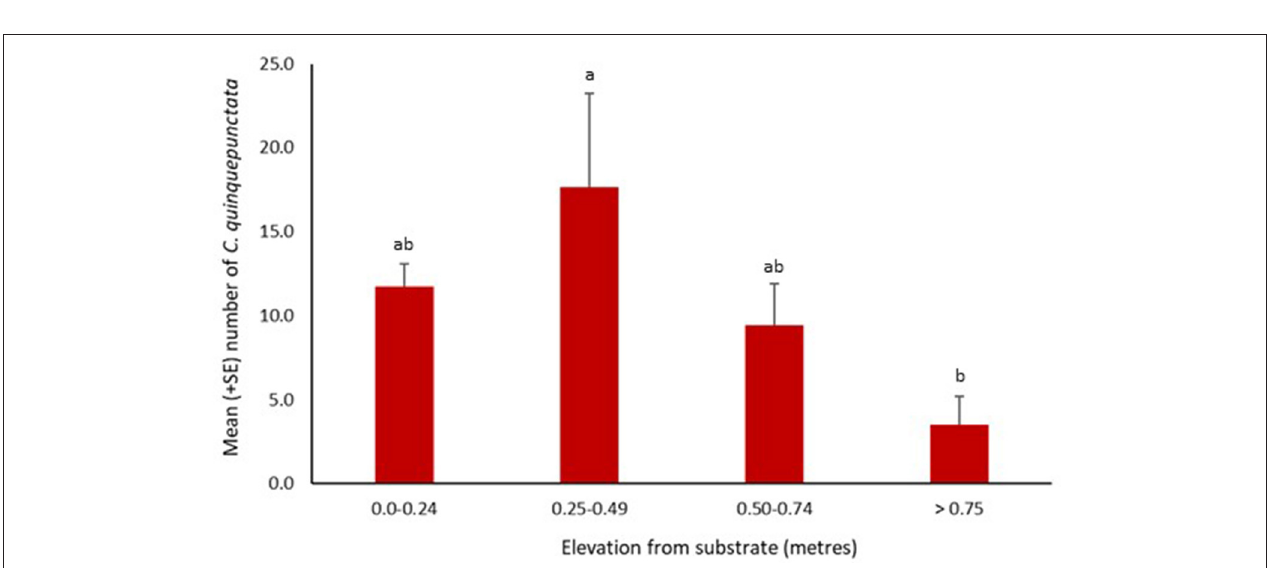
FIGURE 5 | Mean number ( + SE) per site of Coccinella quinquepunctata and the distance (in m) from the substrate they were recorded at in 2017. Consecutive letters indicate where significant differences occur.